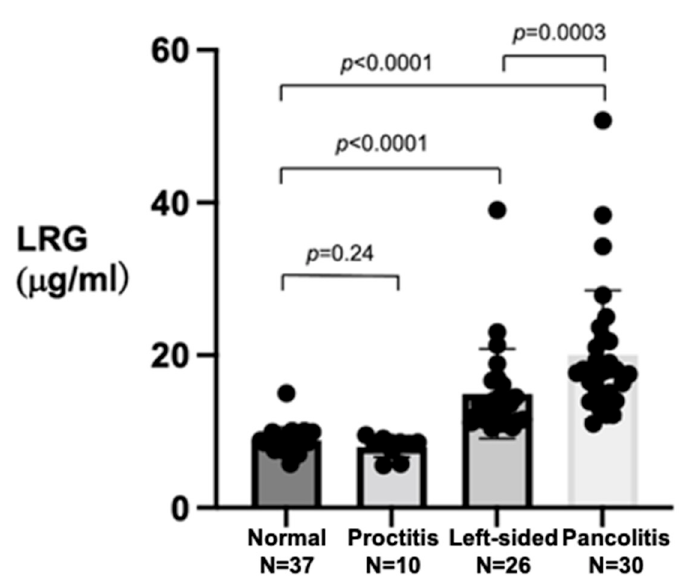
Figure 2. Comparison of median leucine-rich α 2 glycoprotein (LRG) values among patients with normal colonoscopic findings, ulcerative proctitis, left-sided colitis, and pancolitis.